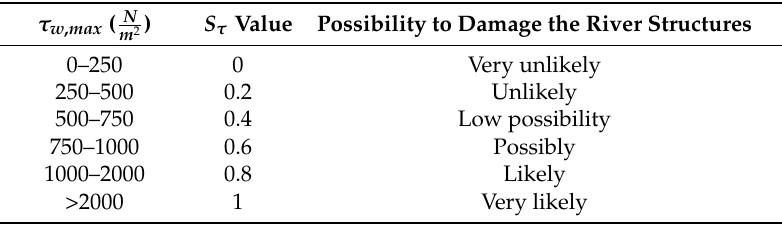
Table 2. S τ for flow-induced shear stress on streambed boundary